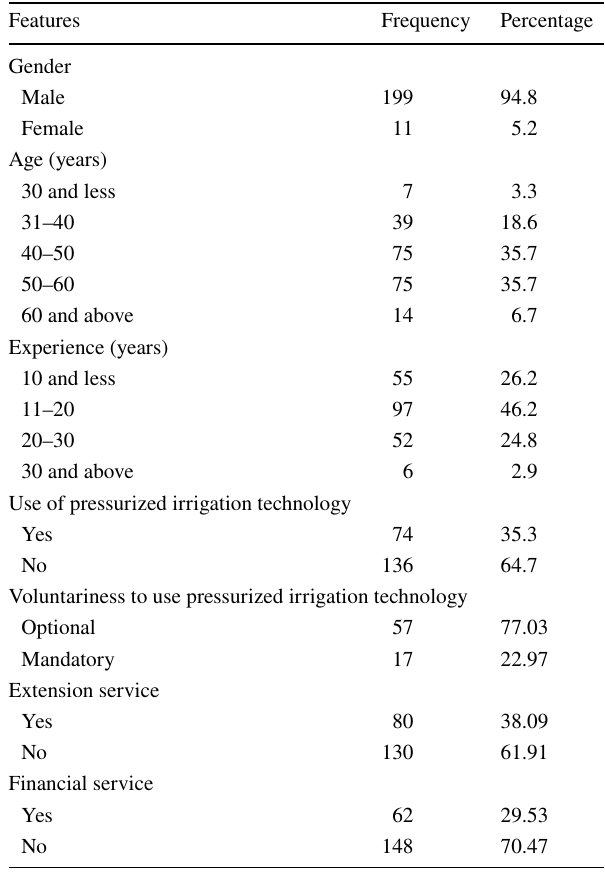
Table 2 Characteristics of the respondents ( n = 210)